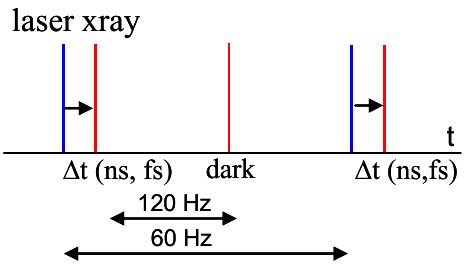
Figure 1. A time-resolved macromolecular crystallography (TRX) experiment with the pump–probe method. The pump laser pulse (blue bar) starts the reaction, and the ultrashort X-ray pulse (red bar) probes the progress of the reaction after a time delay, ∆ t. Here, X-ray data collection in the dark as the reference is interleaved with data collection after laser light activation. The X-ray data collection rate is 120 Hz, as available at the LCLS, and the laser repetition rate is 60 Hz in this example.